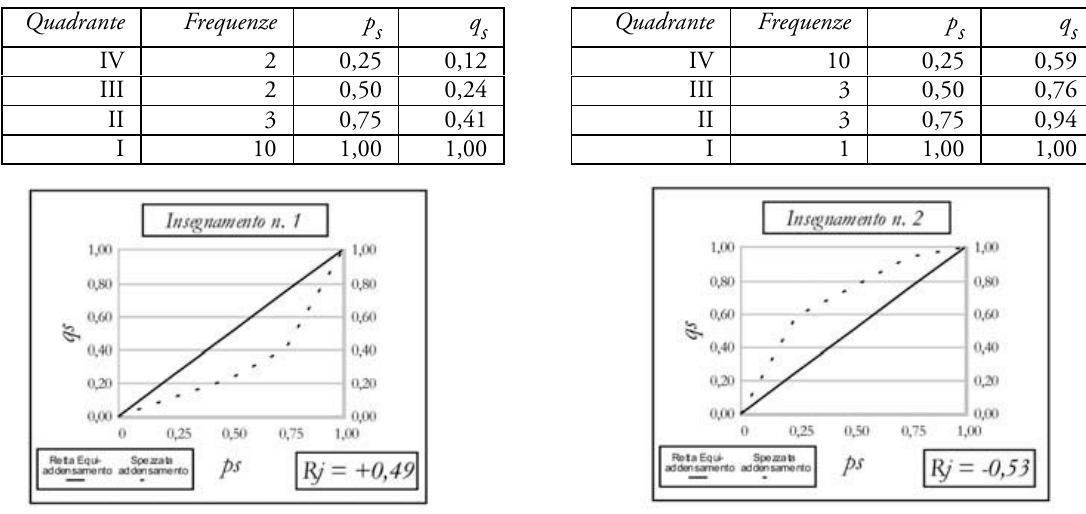
Figura 4 – Rappresentazione grafica della valutazione tramite R j dei due